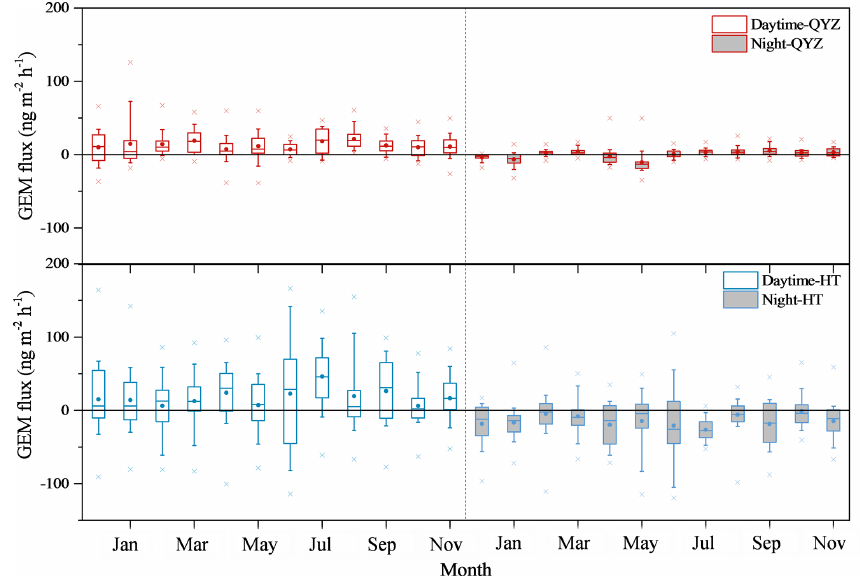
Figure 6. Monthly variation in daytime GEM flux (lower panels) and night GEM flux (under panels) during the measurement periods at sites (a) QYZ and (b) HT. Box horizontal border lines represent the 25th, 50th and 75th percentiles from bottom to top, the whiskers include the 10th and 90th percentiles, and the outliers (cross) represent the minimum and maximum percentiles. The solid circle in the box represents the mean value.